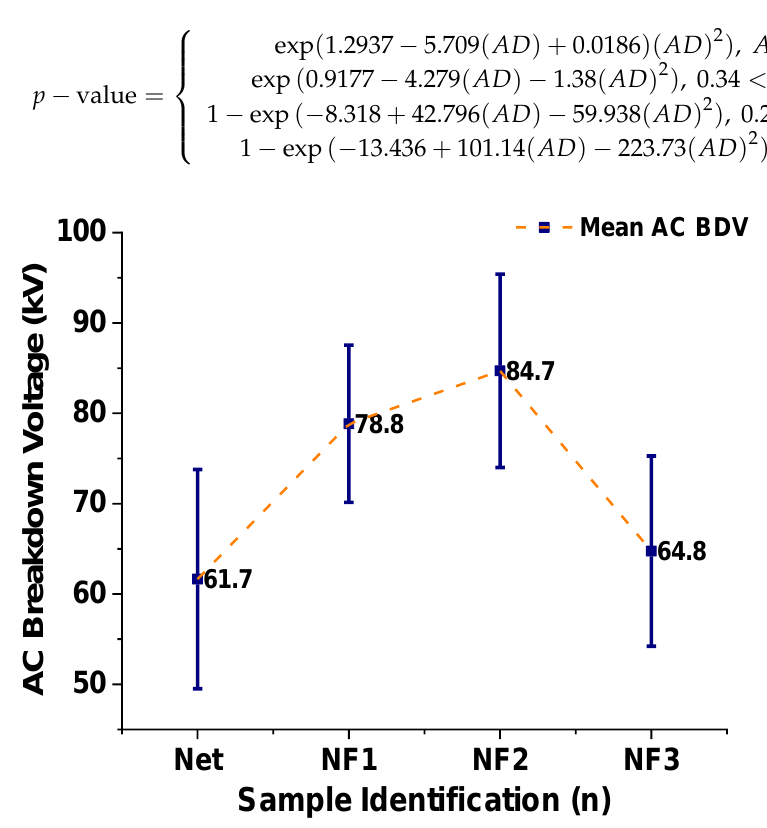
Figure 7. Mean values of the AC BDV along with error bars for the samples in question.